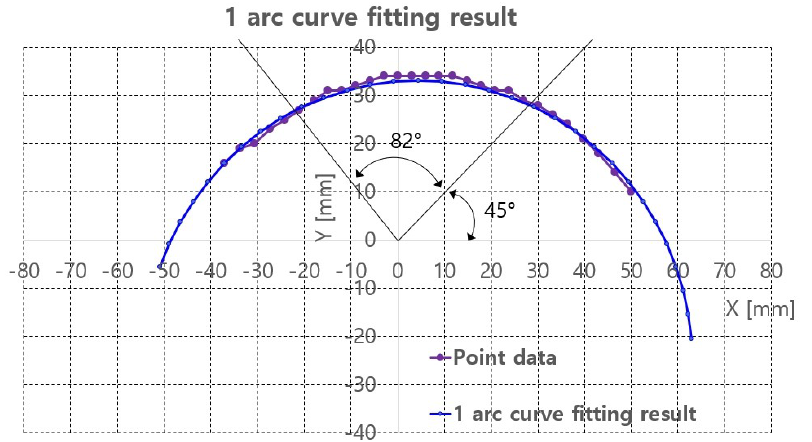
Figure 15. One arc curve fitting results of extracted points of the phantom at z = 105.4